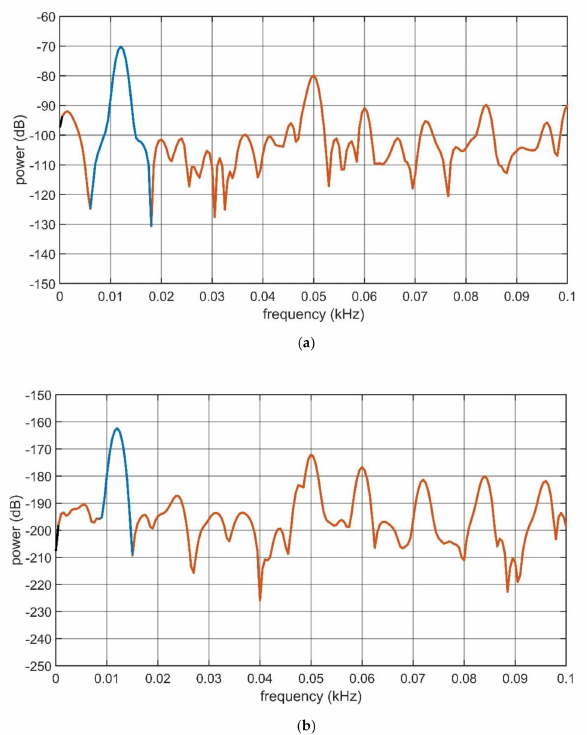
Figure 14. Power spectra of the BC-CP OC voltage ( a ) and SC current ( b ) for the transducer forced at its mechanical resonance frequency (12 Hz).